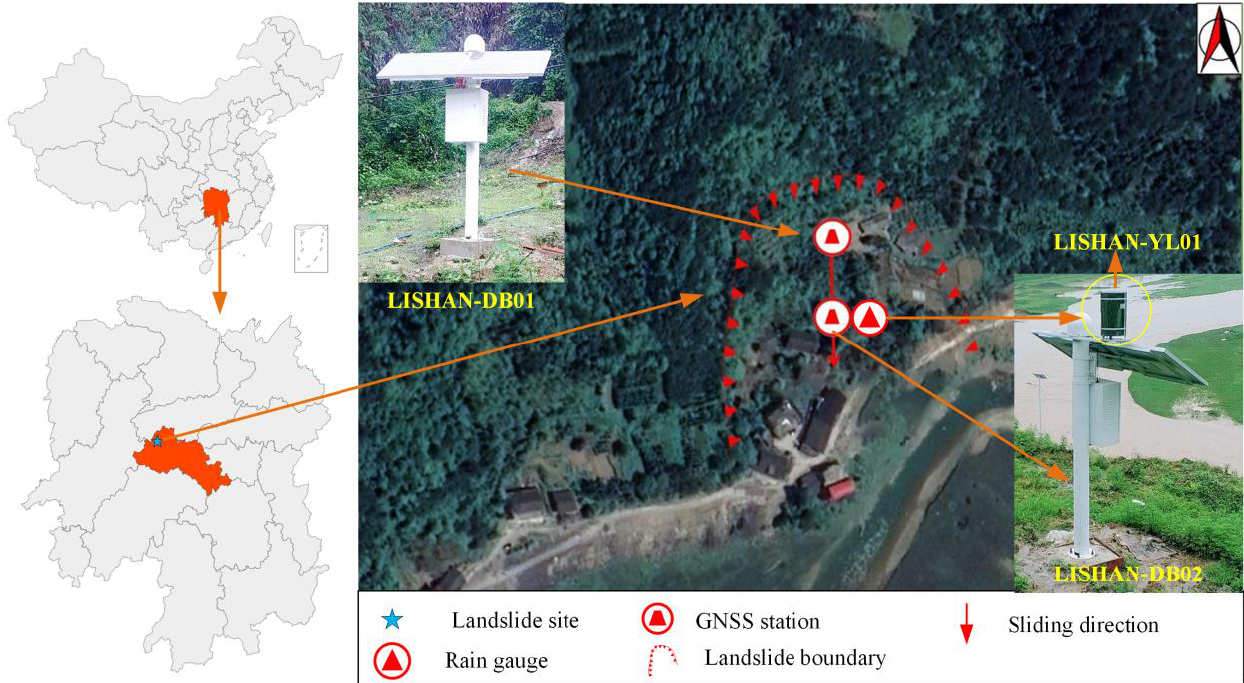
Figure 3. Location of the Lishanyuan landslide and distribution of the monitoring stations.